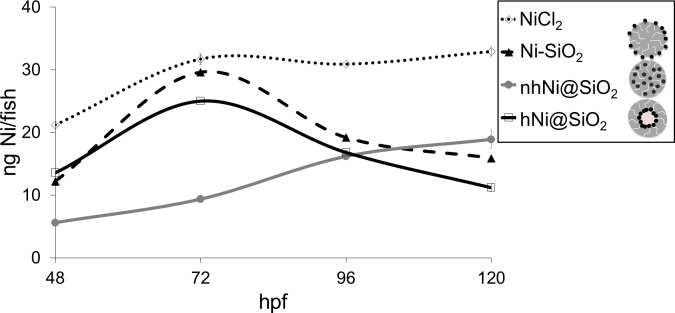
Zebrafish nickel uptake at 48, 72, 96, 120 hpf after exposure to 50 mg Ni/L NiCl2, Ni-SiO2, nhNi@SiO2 and hNi@SiO2.